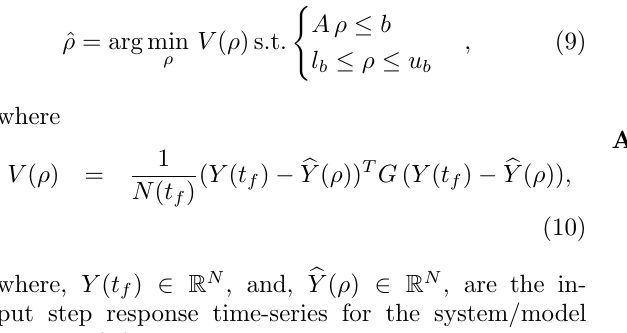
Algorithm 2.1 (Simple δ -PI or PD/PID